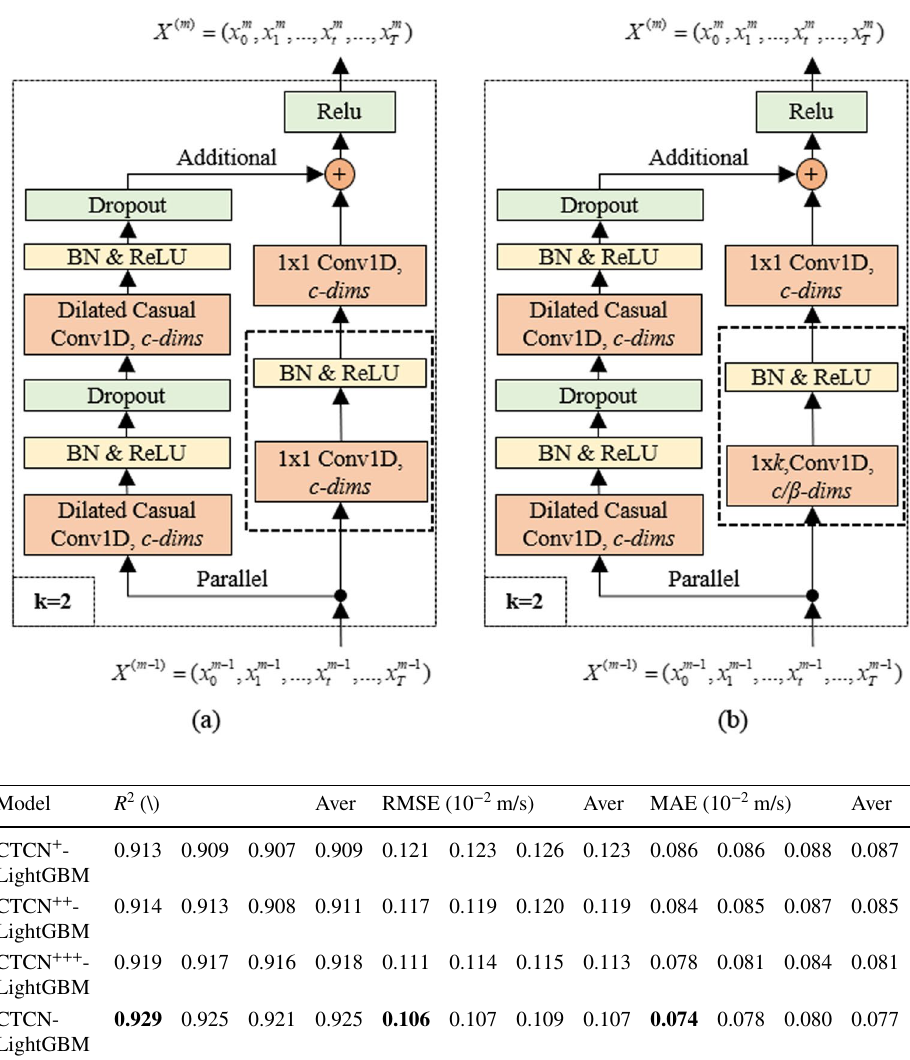
Fig. 6 The residual block structure of the CTCN ++ -LightGBM ( a ) and the CTCN +++ -LightGBM ( b )